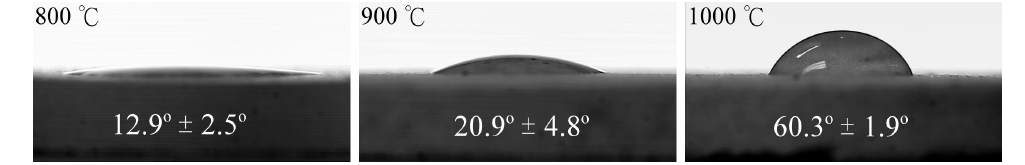
Figure 3. Water contact angles of Ti samples sintered at 800, 900, and 1000 °C in air.